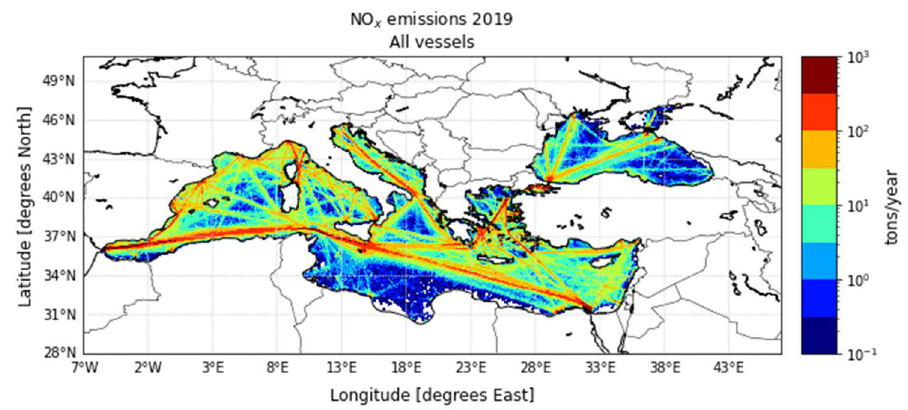
Figure 3. CAMS-GLOB-SHIP v2.1 2019 NO X emissions (tons per year).